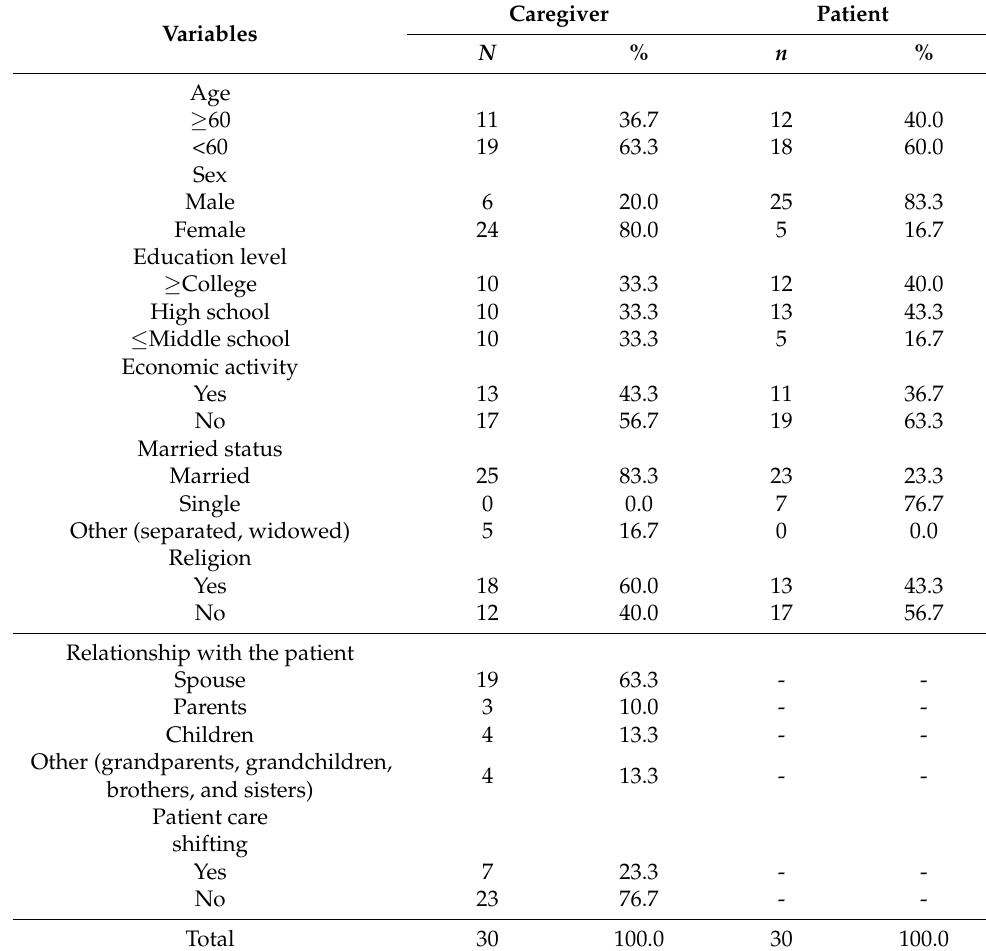
Table 1. General characteristics (caregiver and patient).